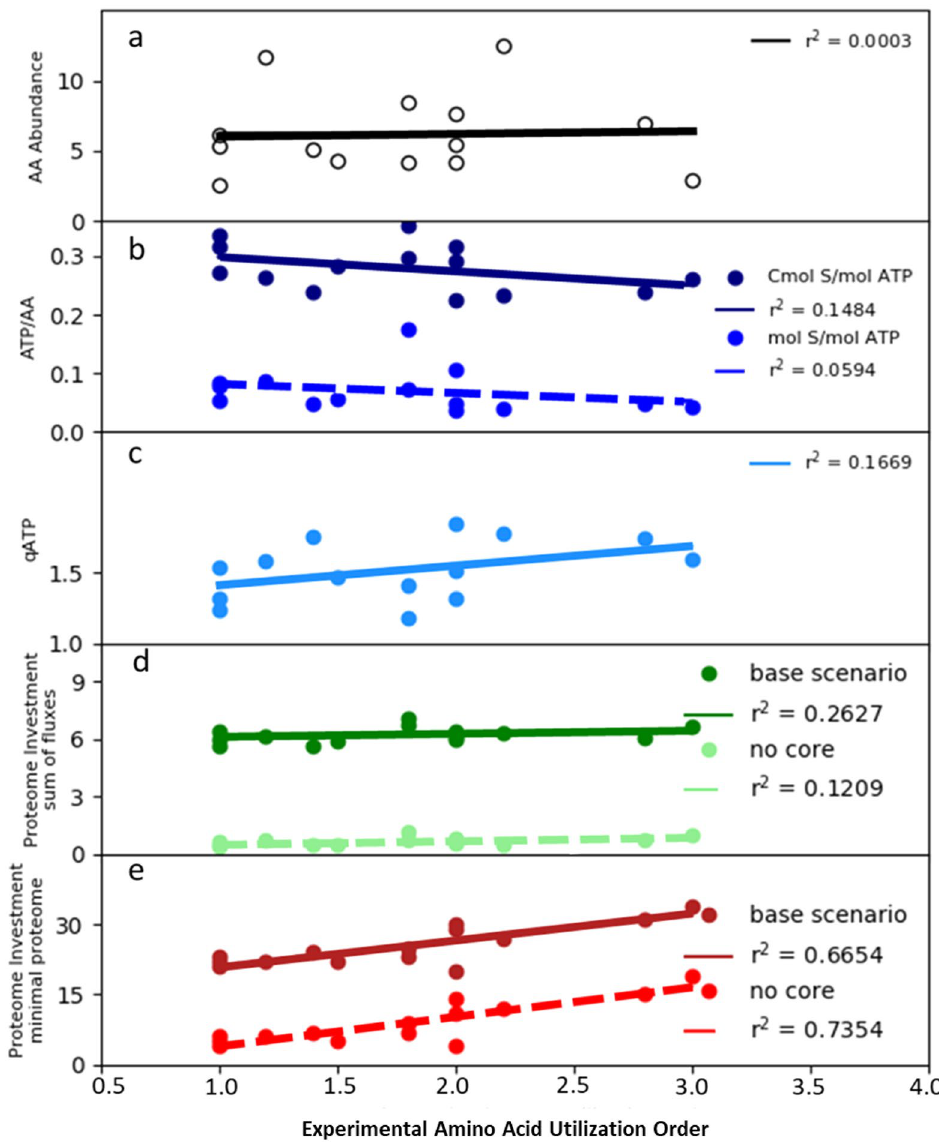
Figure 5. In silico analysis of reverse carbon catabolite repression (rCCR) substrate utilization order in P. aeruginosa 215. ( a ) Amino acid frequency in genome open reading frames plotted as a function of the experimental amino acid utilization order. ( b ) Optimal in silico cellular energy yield from the catabolism of each amino acid plotted as a function of experimental amino acid utilization order. Analysis considered both moles of amino acid and carbon moles (Cmol) of amino acid. ( c ) in silico maximization of cellular energy rate (qATP = mmol ATP g cdw −1 h −1 ) plotted as a function of experimental amino acid utilization order. Enzyme parameters were based on a survey study of catabolic enzymes (0.5 mmol AA g cdw −1 h −1 , K m = 0.2 mM, and CSP G medium composition, see supplementary material S1). ( d ) Computational analysis of amino acid utilization order based on resource investment into proteome for complete oxidation of substrate using the sum of fluxes as a proxy for proteome investment. Analysis considered a base metabolism scenario where all enzyme-catalyzed reactions were considered and a refined, no core metabolism scenario where only enzyme- catalyzed reactions extraneous to the experimentally-measured, constitutive proteome core where considered. A subset of the core enzymes is shown in Fig. 3 while an explicit list can be found in supplementary material S15. ( e ) Proteome investment analysis using the minimal proteome investment proxy to predict experimental amino acid utilization order. Analysis considered base metabolism scenario and refined, no core metabolism